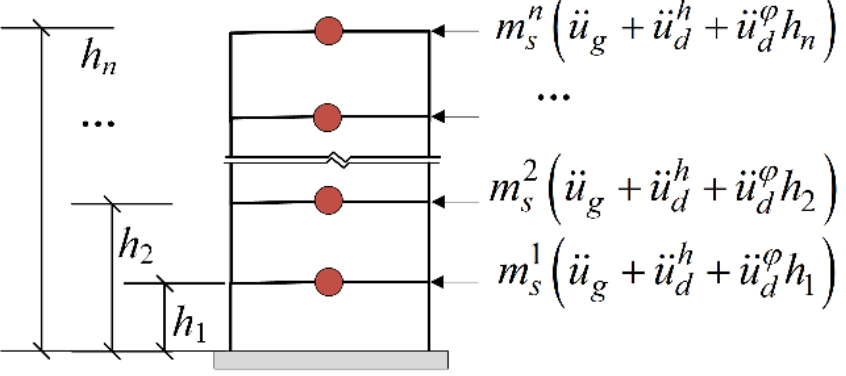
Figure 5. Schematic of loads applied to the structure.